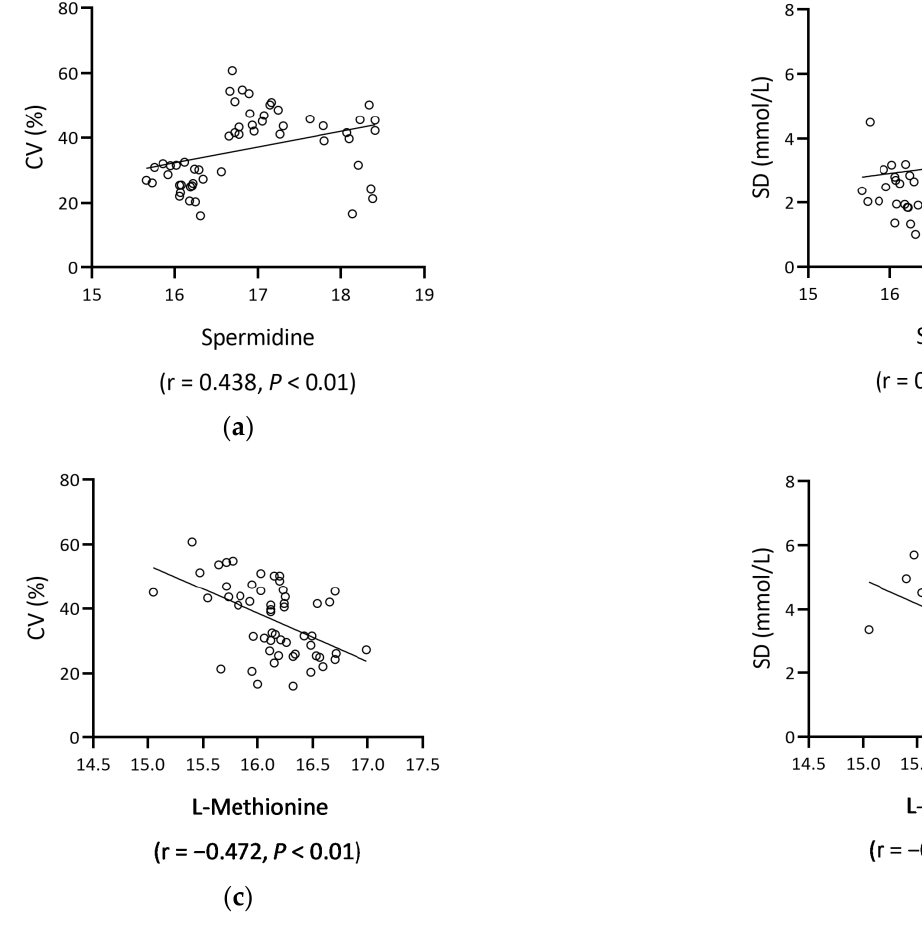
Figure 4. Scatter plots of spermidine/L-methionine and GV metrics (glucose CV, SD). Spermidine positively correlated with glucose CV (Figure ( a ), r = 0.438, P < 0.01) and SD (Figure ( b ), r = 0.361, P < 0.01), and L-methionine negatively correlated with glucose CV (Figure ( c ), r = −0 .472, P < 0.01) and SD (Figure ( d ), r = −0 .473, P < 0.01). Abbreviations: CV, coefficients of variation; SD, standard devi- ation.